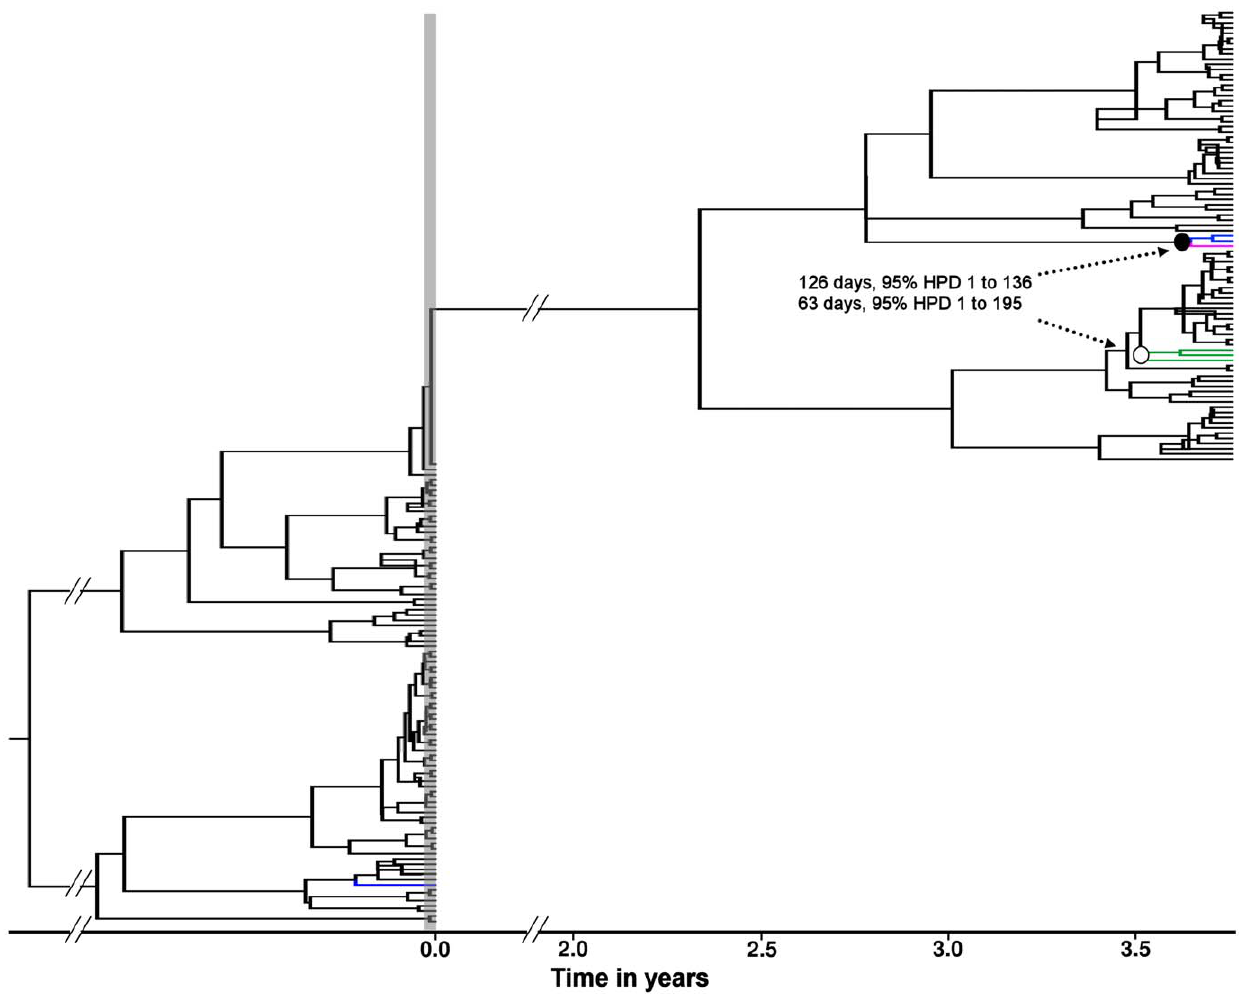
N Figure 5. Molecular clock phylogeny from patient 15. The tree represents the maximum clade credibility tree from the Bayesian MCMC =126 days, 95% HPD 1 - 360) and T54A/S ( # = 63 days, 95% HPD 1 - analysis. The bullets at the nodes indicate the tMRCA estimates for the V36M ( 195) resistant variants. The V36M, T54A and T54S mutations are indicated in green, blue and pink respectively. The vertical grey shaded bar indicates the TVR-treatment period. Time scale in years relative to the EOT period is indicated on the